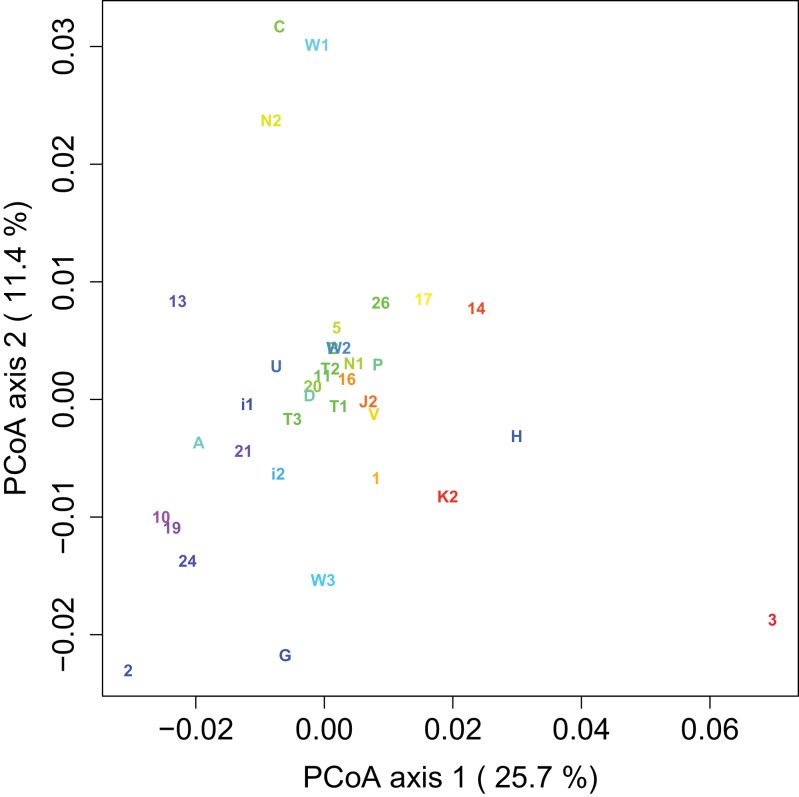
Site-level PCoA.PCoA of Fst between sampling sites. Sampling sites are labeled by name and color coded to match the map in Figure 1A. The percentage on each axis indicates how much of the variation in Fst between sampling sites was explained by the axis.